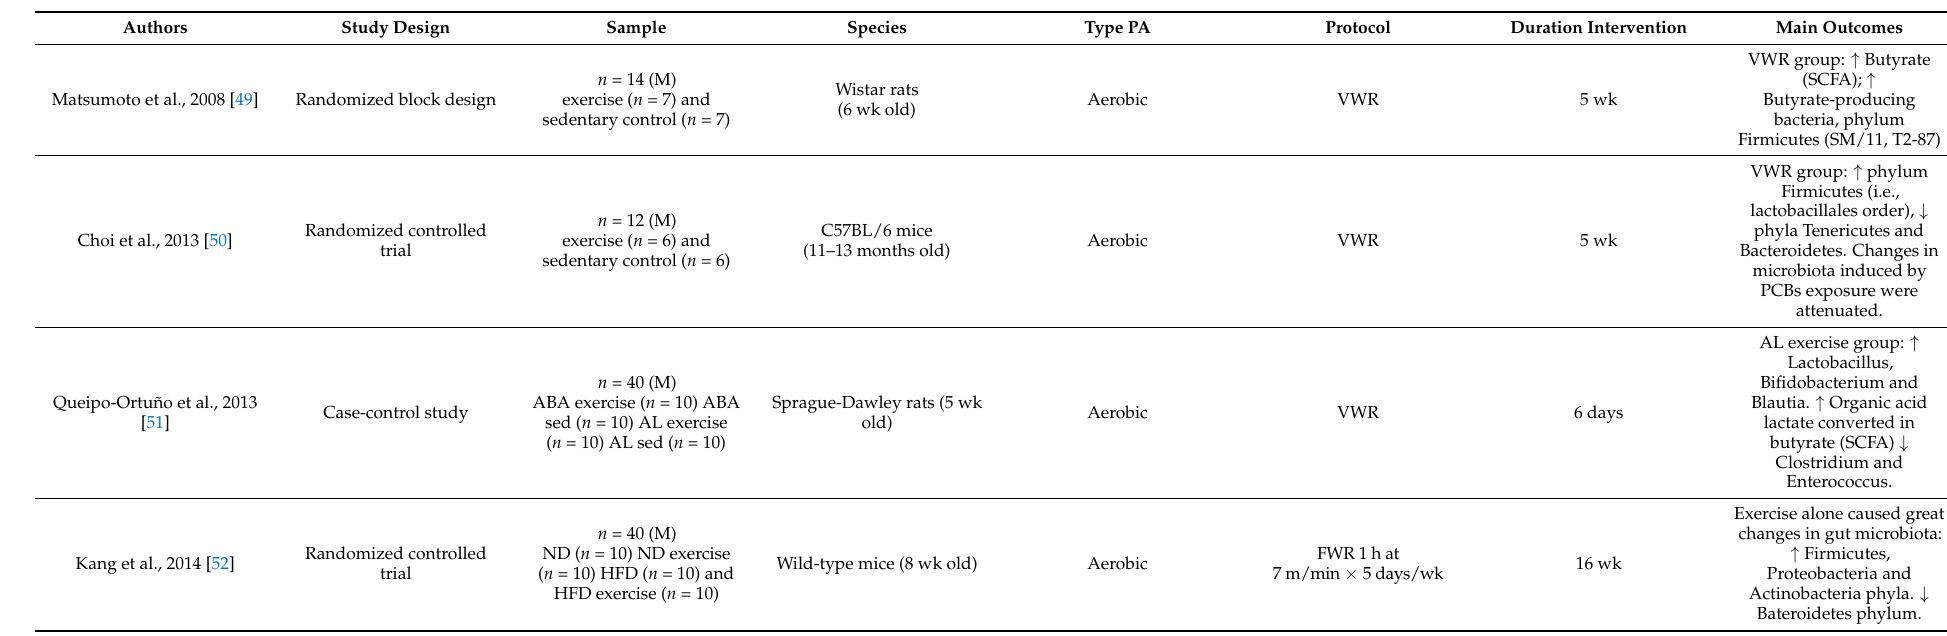
Table 2. Summary characteristics of reviewed pre-clinic